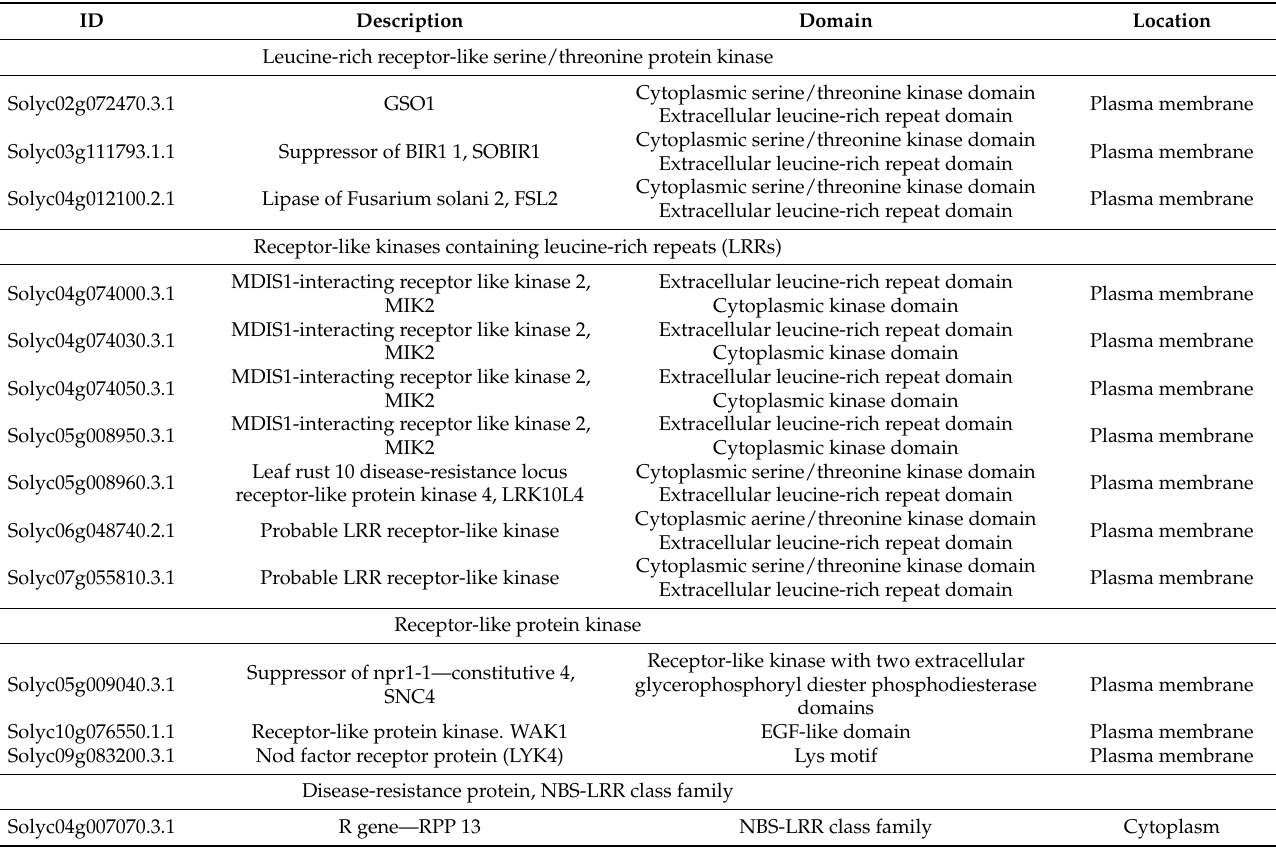
Table 3. Receptors identified in response to priming treatment